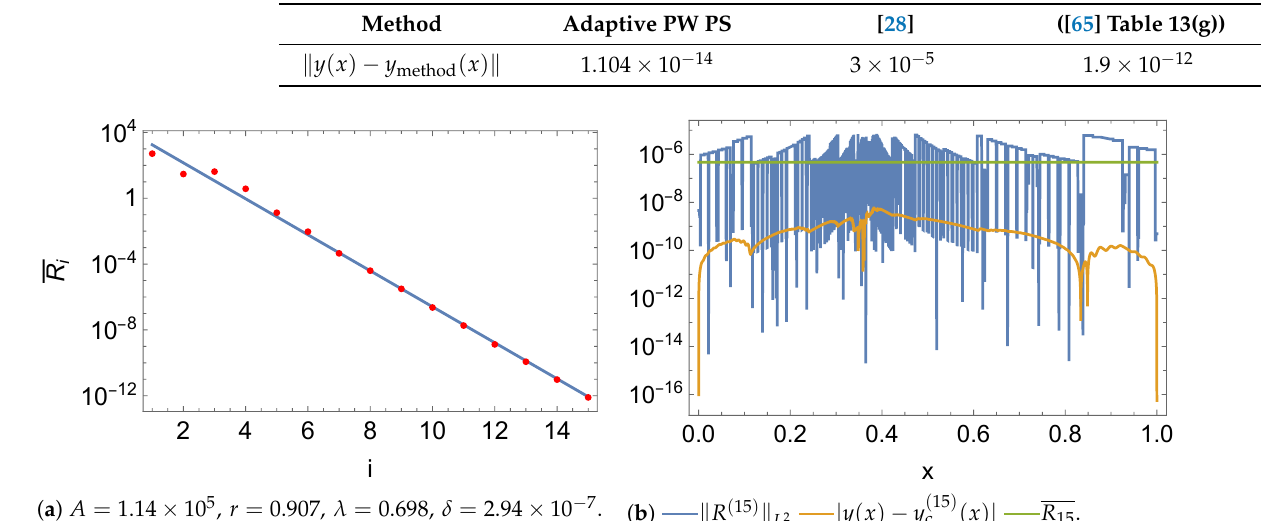
Figure 17. ( a ) Fitting the upper bound (24) with the set R . ( b ) Visualization of the residual, absolute local approximation error, and the mean